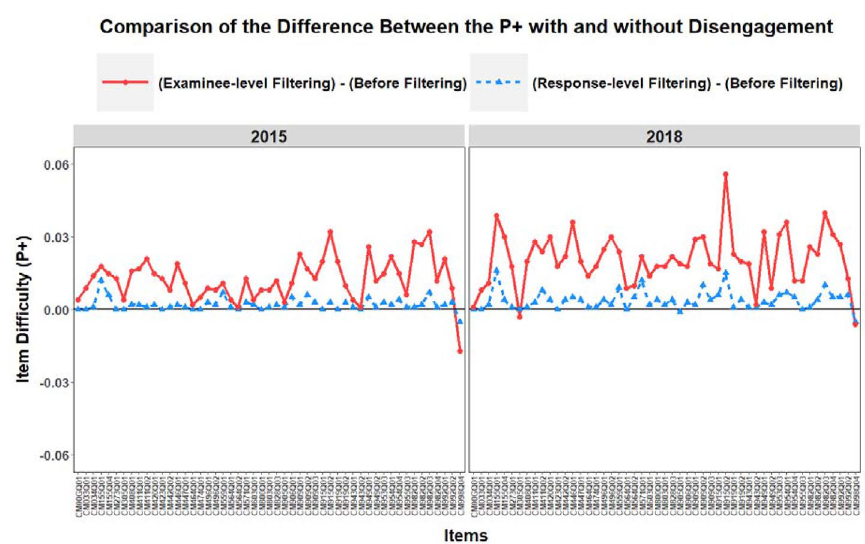
Fig. 4 Comparison of the difference between the P with disengagement and without disengagement. The + blue line refers to the difference between P with disengagement and after applying response-level filtering; + and the red line refers to the difference between P with disengagement and after applying examinee-level + filtering. Source : Organisation for Economic Cooperation and Development (OECD), Programme for International Student Assessment (PISA), 2015 and 2018 Mathematics